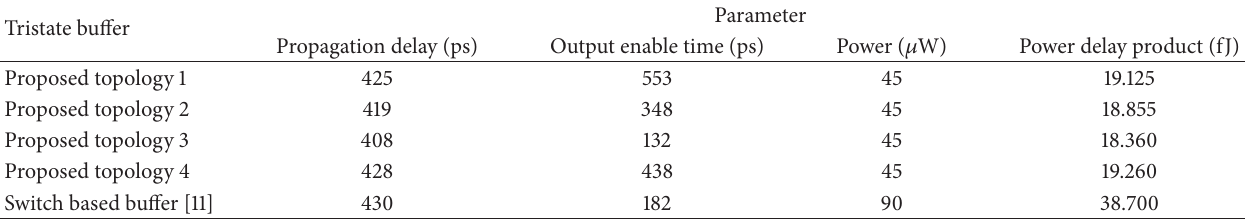
Table 1: Summary of performance parameters for proposed and available PFSCL tristate